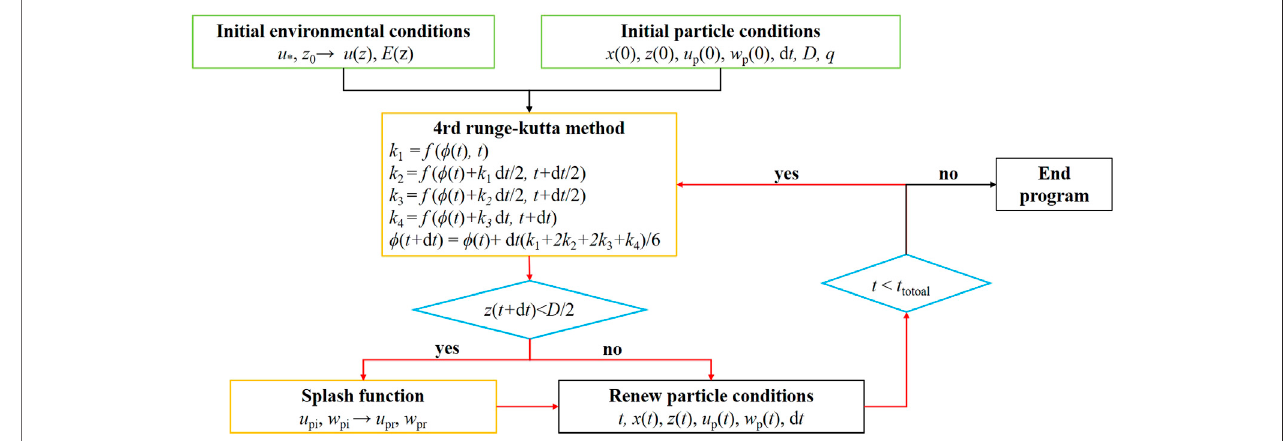
for an ejection particle, and 3 m/s for a rebound particle. From Figure 4 we can conclude that: The saltation height and length of the particles with the same charge but different ways of jumping are almost the same. Generally, negative particles are closer to the ground surface with a shorter saltation length, and positive particles move to a higher position which results in greater saltation length.